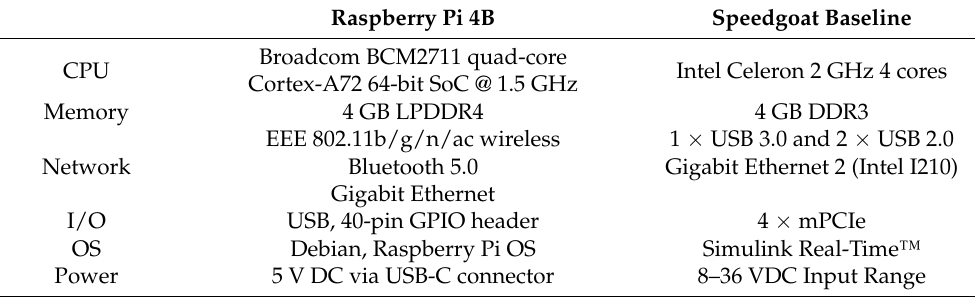
Table 2. Hardware specification of the Raspberry Pi 4B board and Speedgoat Baseline real-time target